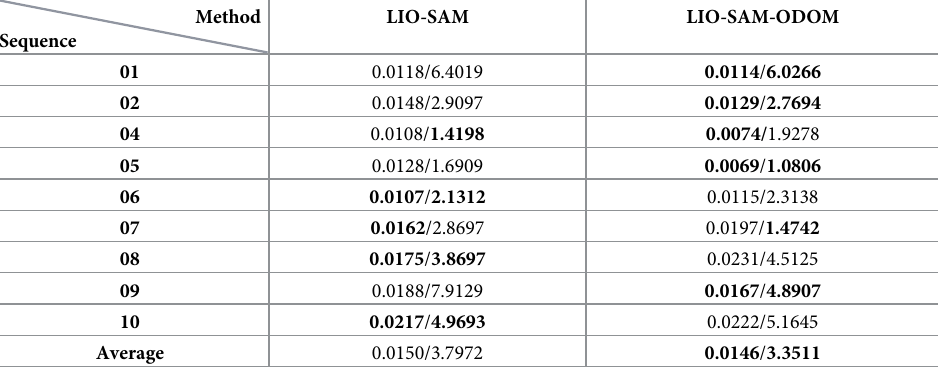
Table 4. Relative pose error of LIO-SAM and LIO-SAM-ODOM.